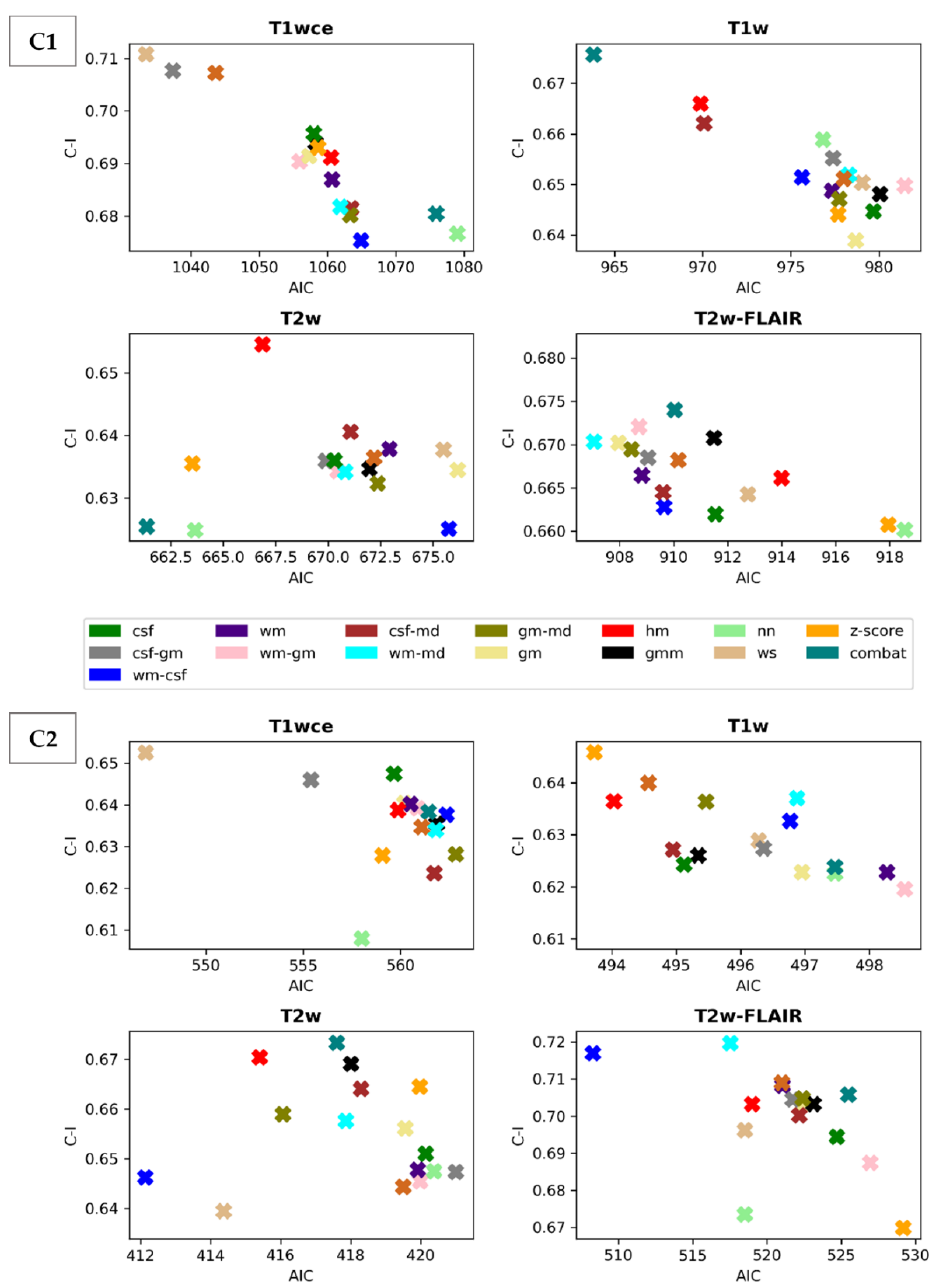
Figure 3. Scatter plots of the averaged (over the five bin counts considered) C-index vs AIC obtained by the CPH models for all four sequences in the study. Upper panel: cohort C1, Lower panel: cohort C2. csf: cerebrospinal fluid, wm: white matter, gm: grey matter, md: mode, gmm: Gaussian mixture models, kde: kernel density estimation, hm: Nyúl/Udupa histogram matching, ws: white stripe, nn: no normalization.